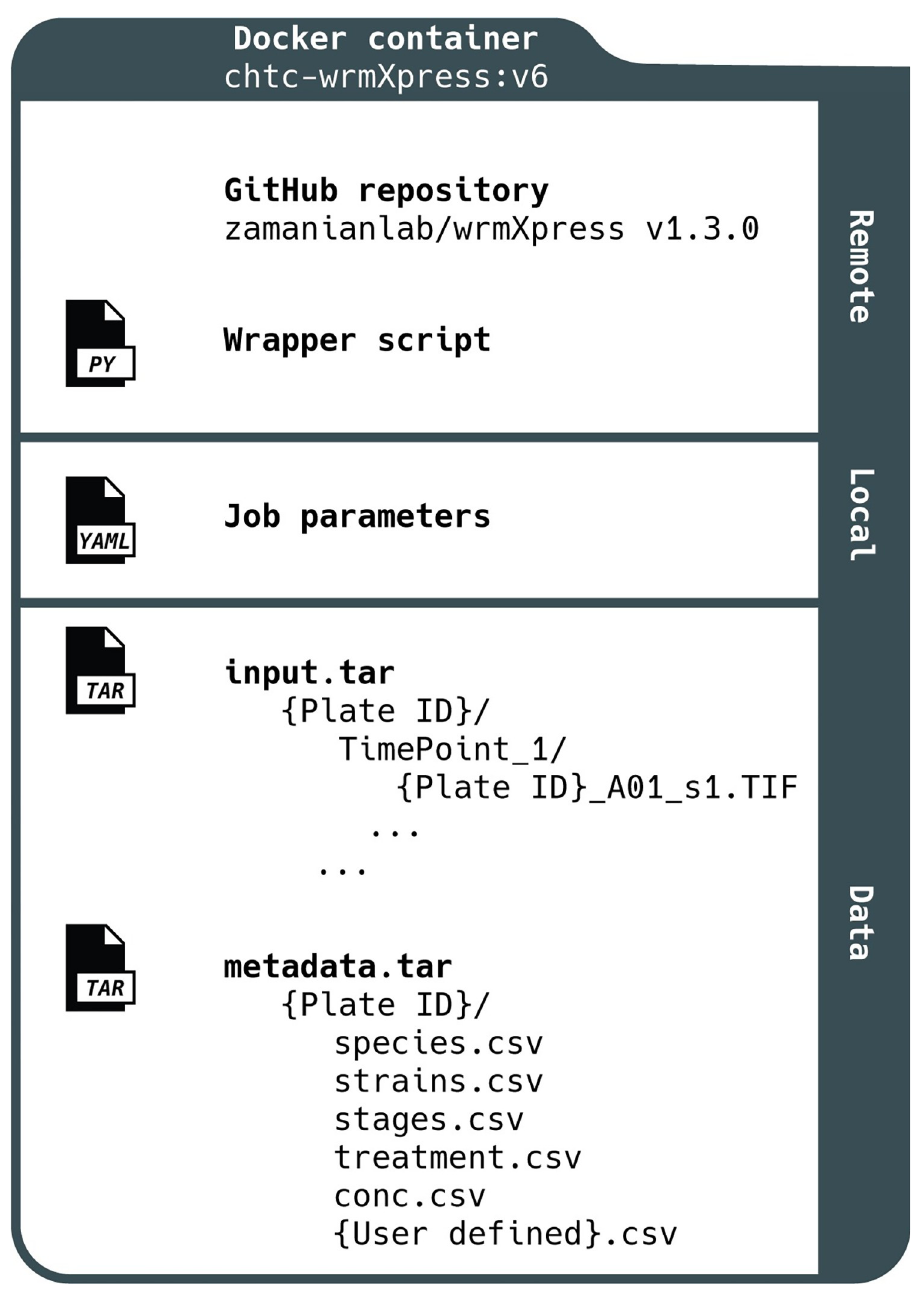
Fig 1. Schematic of wrmXpress. wrmXpress consists of code that is held in a public GitHub repository (including the master wrapper script), job parameters that are edited locally, and external data and metadata. The structure of input data and metadata requires specific formats in order for wrmXpress to complete without